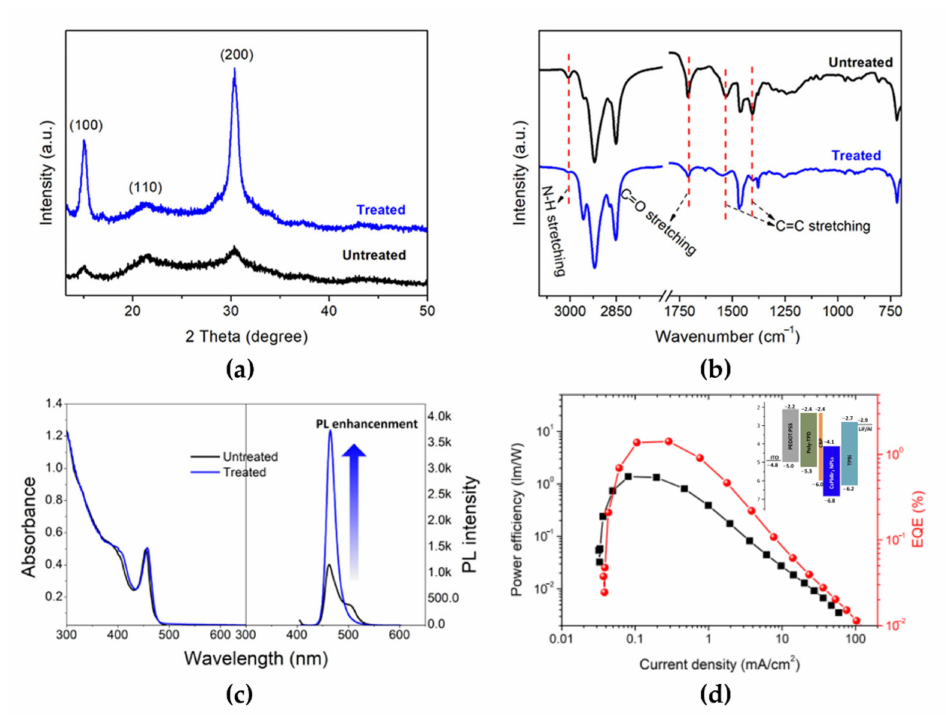
Figure 12. ( a ) XRD patterns, ( b ) FTIR patterns, and ( c ) absorption and PL spectra of untreated and treated CsPbBr 3 NPLs. ( d ) Power efficiency and EQE curves as a function of current density for the treated CsPbBr 3 NPL-based PeLEDs (inset: energy-level diagram of the CsPbBr 3 NPLs-based PeLED with a bilayer hole transport layer structure). Reprinted with permission from [85], Copyright 2019 American Chemical